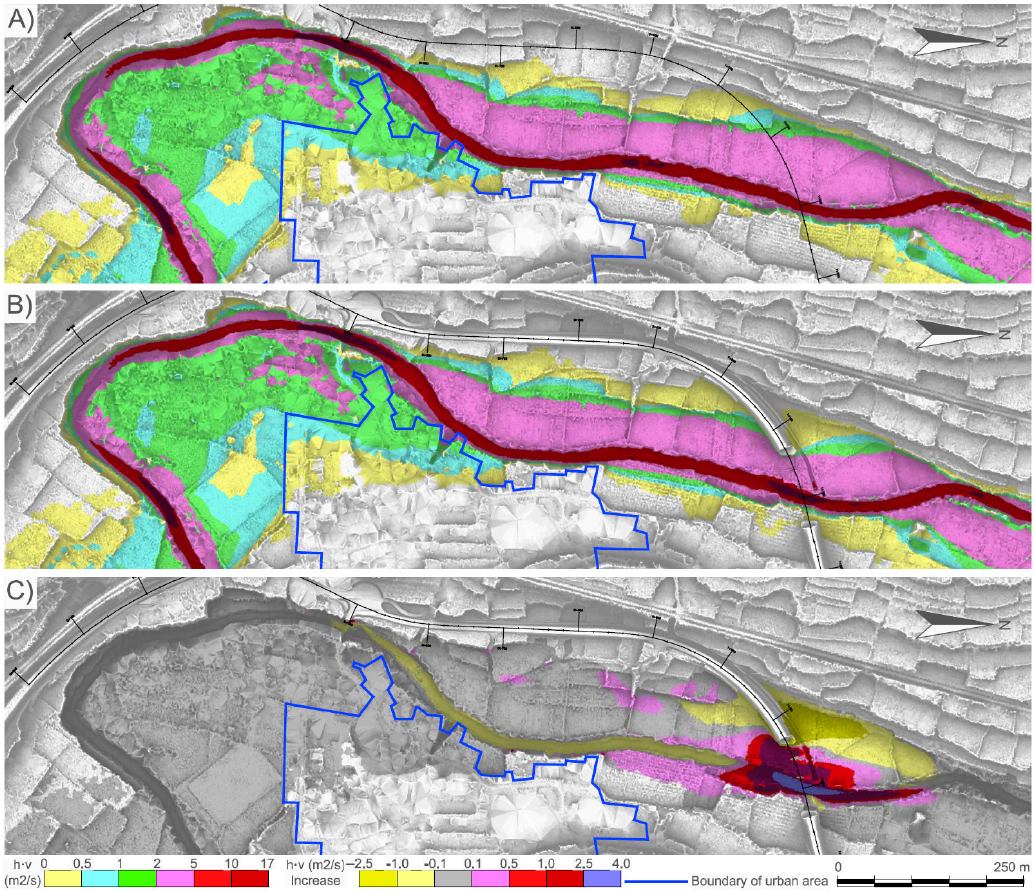
Figure 5. Coverage Flood Hazard Rating (FHR) (h·v) for ( A ) initial state without bridge, and ( B ) state with option’s 3 bridge, ( C ) representation of the difference between the two previous coverages.